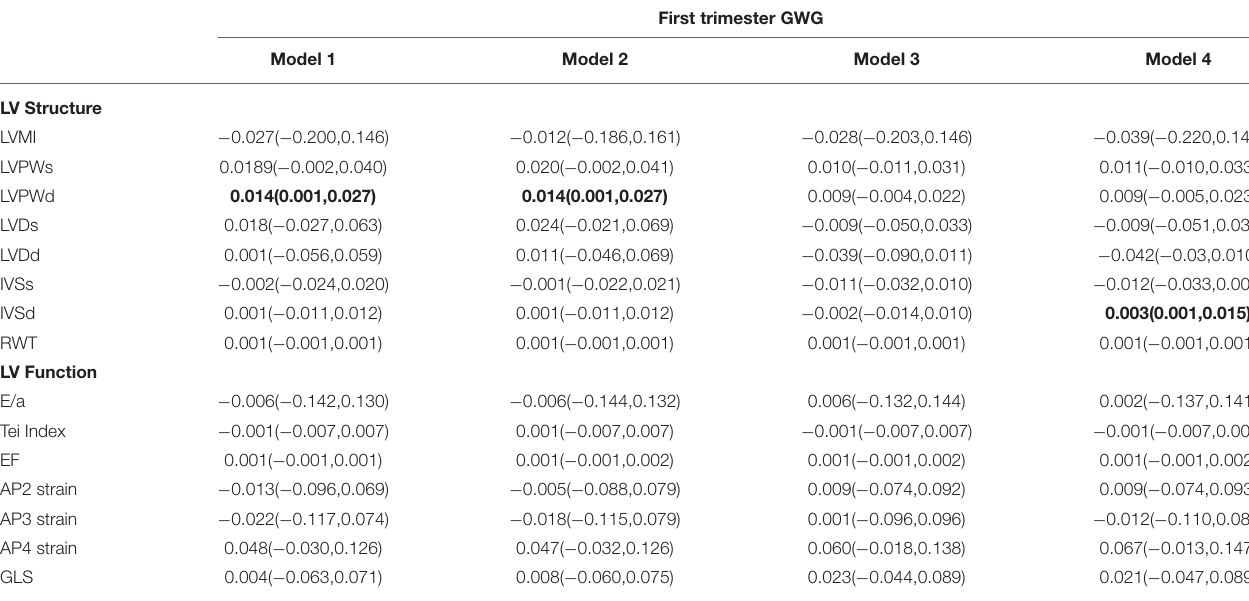
TABLE 2 | Association between maternal GWG and offspring LV geometry and function in the first